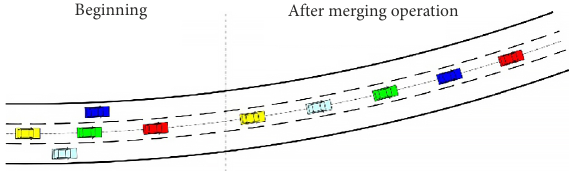
Figure 1. Example of merging